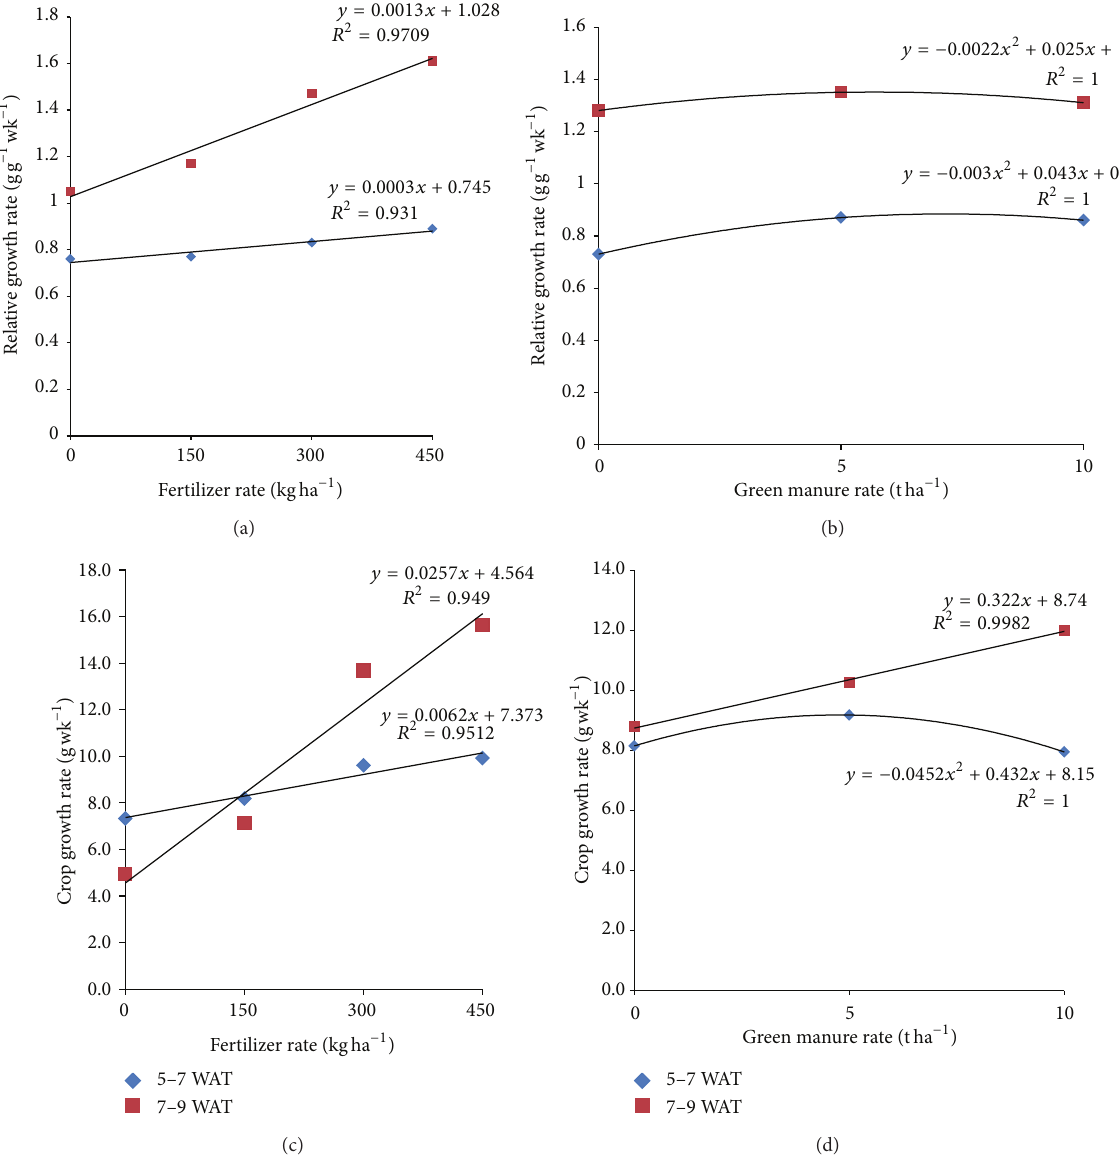
Figure 2: Effect of NPK fertilizer and green manure rate on the relative growth rate (a) and (b) and crop growth rate (c) and (d) of tomato.